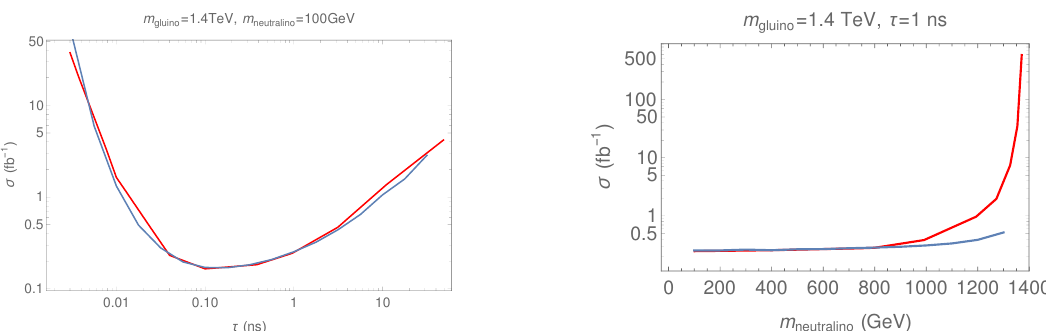
Figure 17. Validation of the DV + MET search performed by ATLAS [71] by comparing the ATLAS results (red) with the results from our recasting (blue). Left: upper limit on the production cross section vs. the gluino lifetime for a fixed gluino mass (1.4 TeV) and neutralino mass (100 GeV). Right: upper limit on the production cross section vs the mass of the neutralino for a fixed gluino mass (1.4 TeV) and gluino lifetime (1 ns). Notice the discrepancy between the ATLAS limit and our result for a small gluino-neutralino mass splitting ( ∆ m/m . 0 . 4 ) which is due to the omission of one of the selection criteria (see the text for